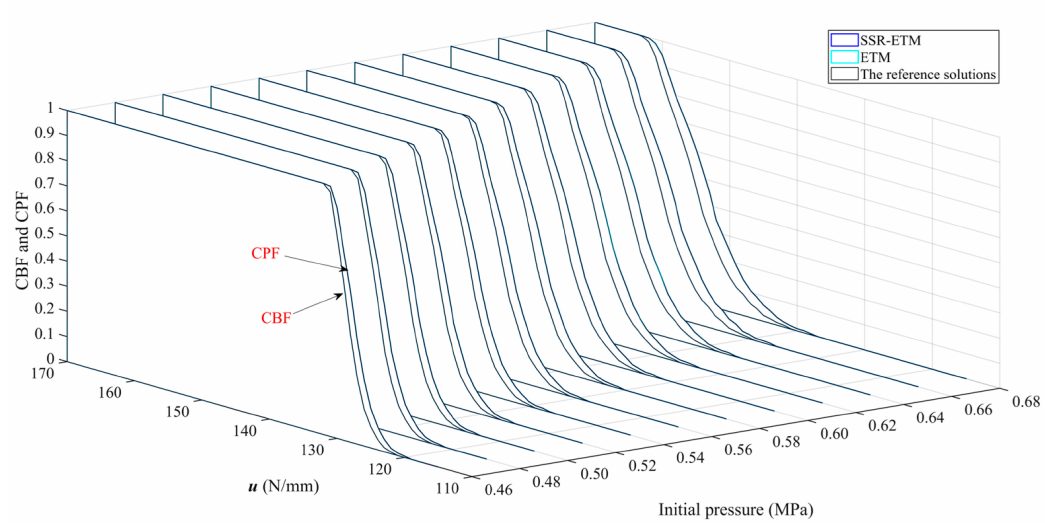
Figure 9. CBF and CPF of the two methods and their reference solutions for the air spring system.